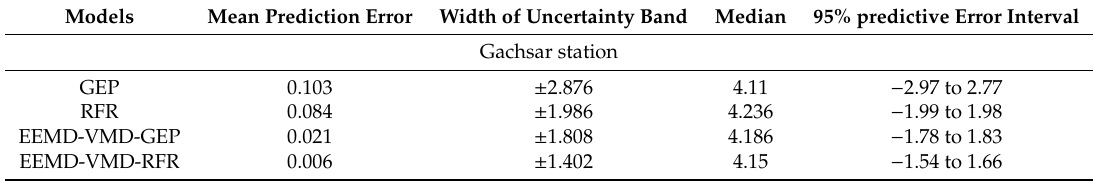
Table 10. Uncertainty analyses for streamflow prediction using predictive models at Gachsar station.